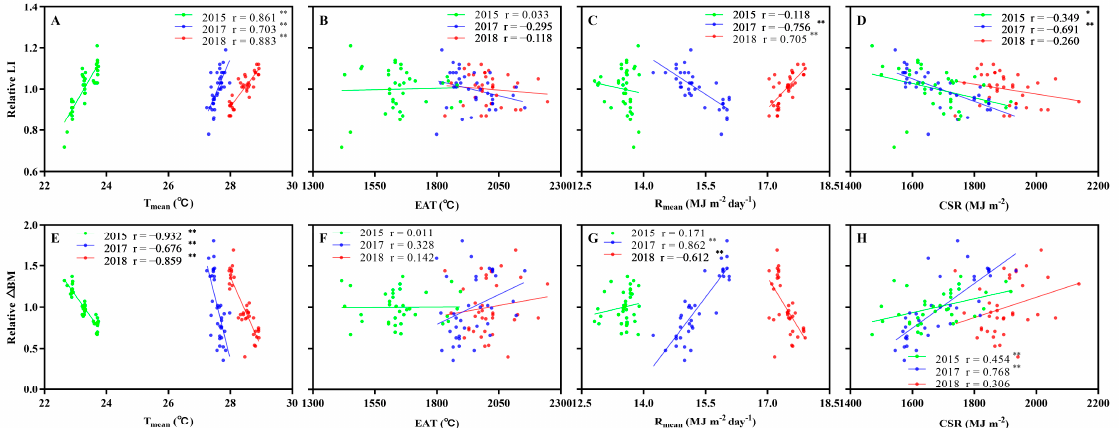
Figure 4. Correlations between the relative LI of the twelve indica rice cultivars and average daily temperature ( T mean ) ( A ) and solar radiation ( R mean ) ( B ), effective accumulated temperature (EAT) ( C ) and cumulative solar radiation (CSR) ( D ) on the three sowing dates of each year. Correlations between the relative △ BM of the twelve indica rice cultivars and T mean ( E ), R mean ( F ), EAT ( G ), and CSR ( H ) on the three sowing dates of each year. The green, blue, and red points represent the cultivars measured in 2015 at Xindu, and in 2017 and 2018 at Ezhou, respectively. n = 36 in each year. * and **, significant differences at p < 0.05 and p < 0.01, respectively.